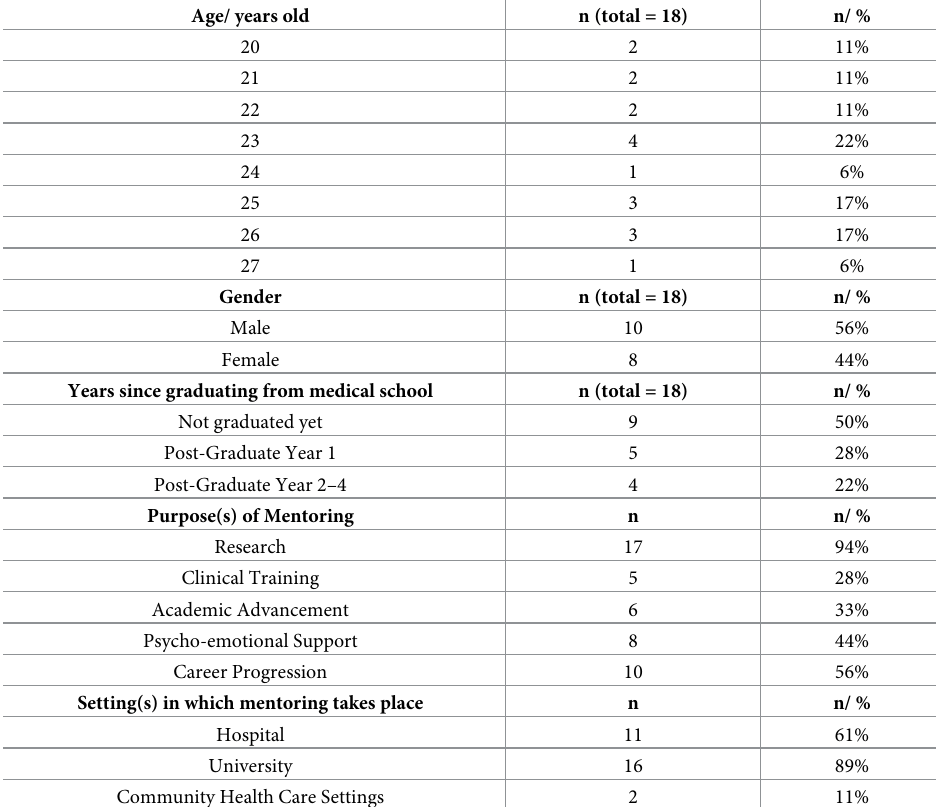
Table 2. Mentee’s